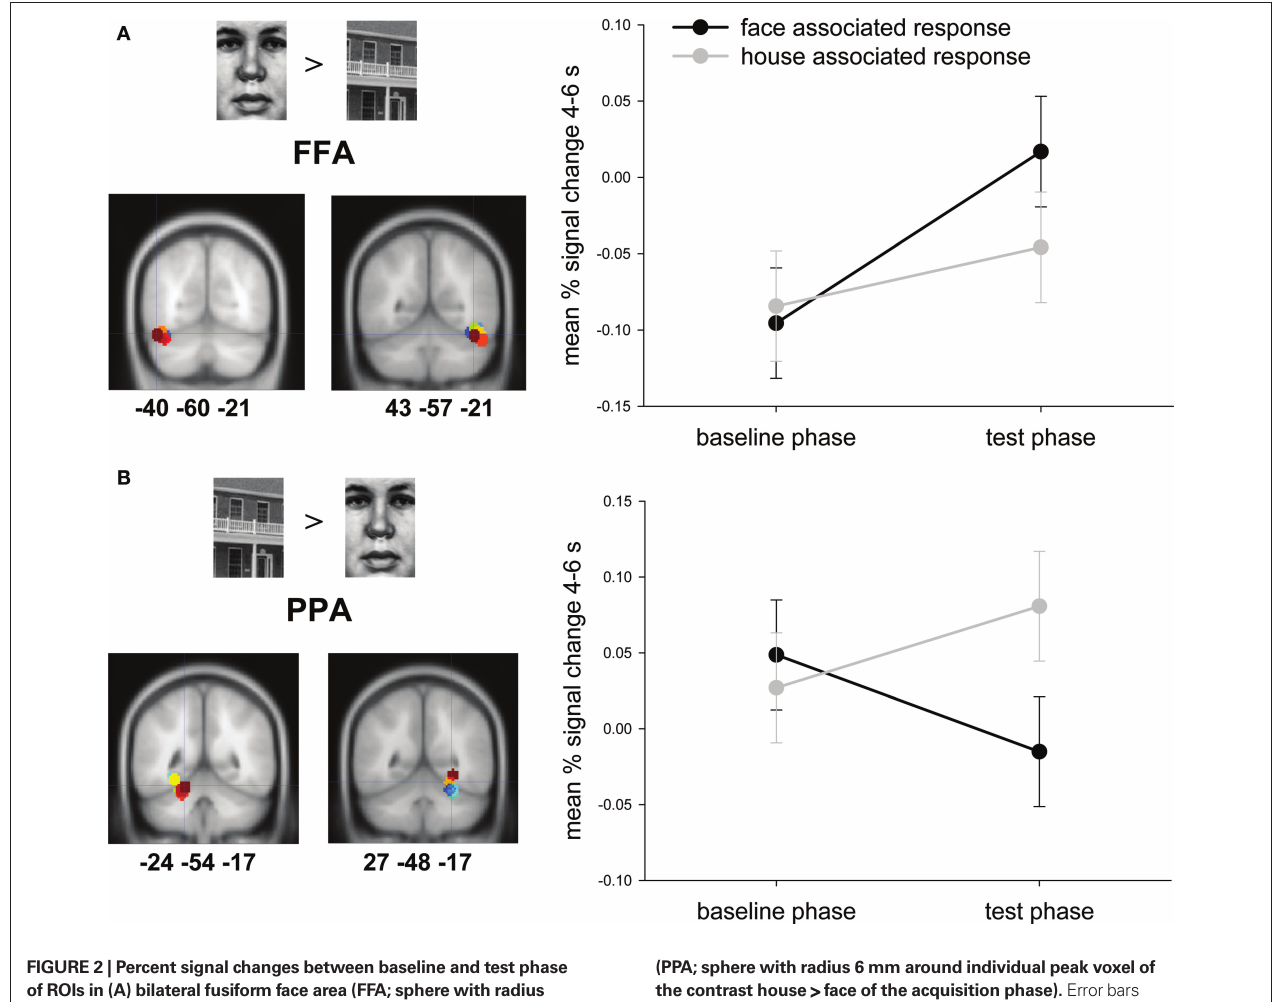
Figure 2 | Percent signal changes between baseline and test phase of rOis in (A) bilateral fusiform face area (FFA; sphere with radius 6 mm around individual peak voxel of the contrast face > house of the acquisition phase) and (B) bilateral parahippocampal place area